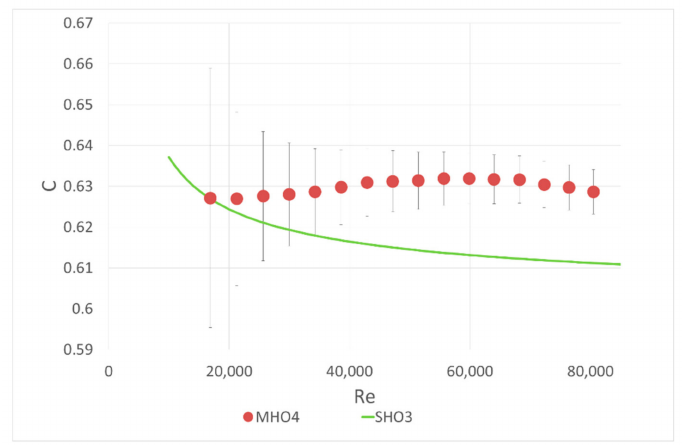
Figure 6. Comparison of the flow coe ffi cients for SHO3 and MHO4 with the same contraction coe ffi cient β = 0.7.